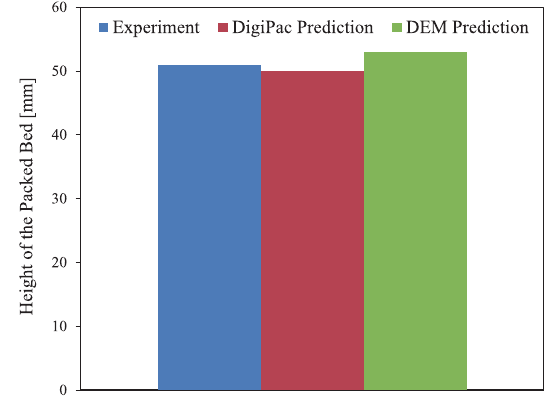
Fig. 1 Experimental and numerical results of the packing behav- ior of spherical